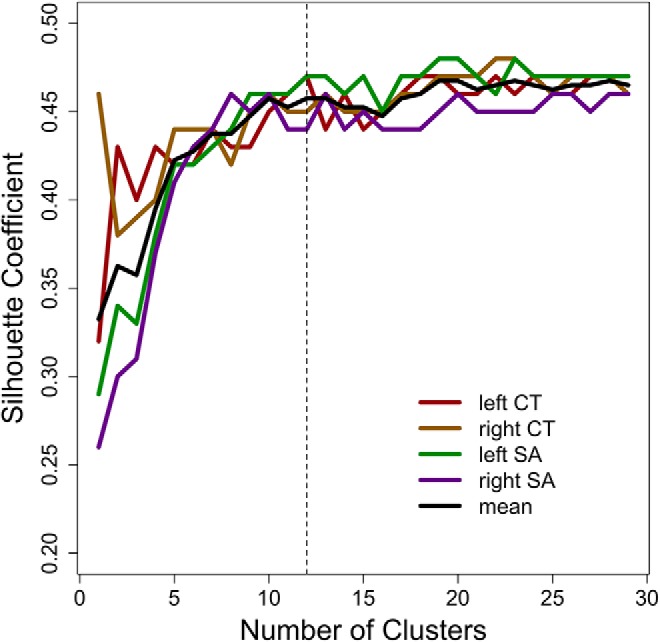
Silhouette coefficients of the clustering scenarios. Vertical dashed line corresponds to 12 clusters per hemisphere and measurement, which we used to parcellate the cortex.